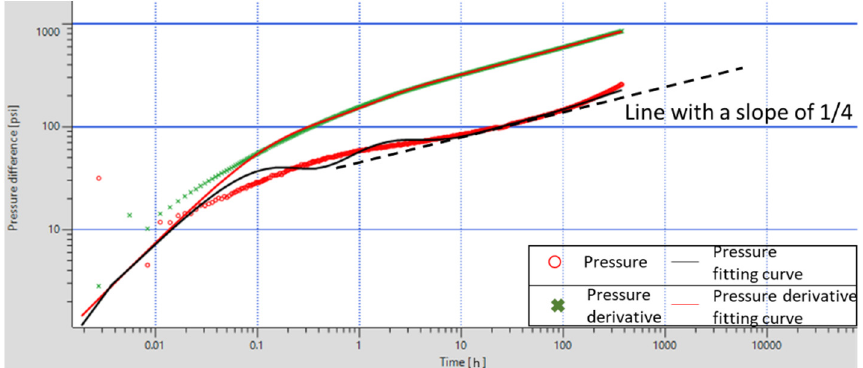
Figure 7. Horizontal well test curve with linear flow slope of 1/2.